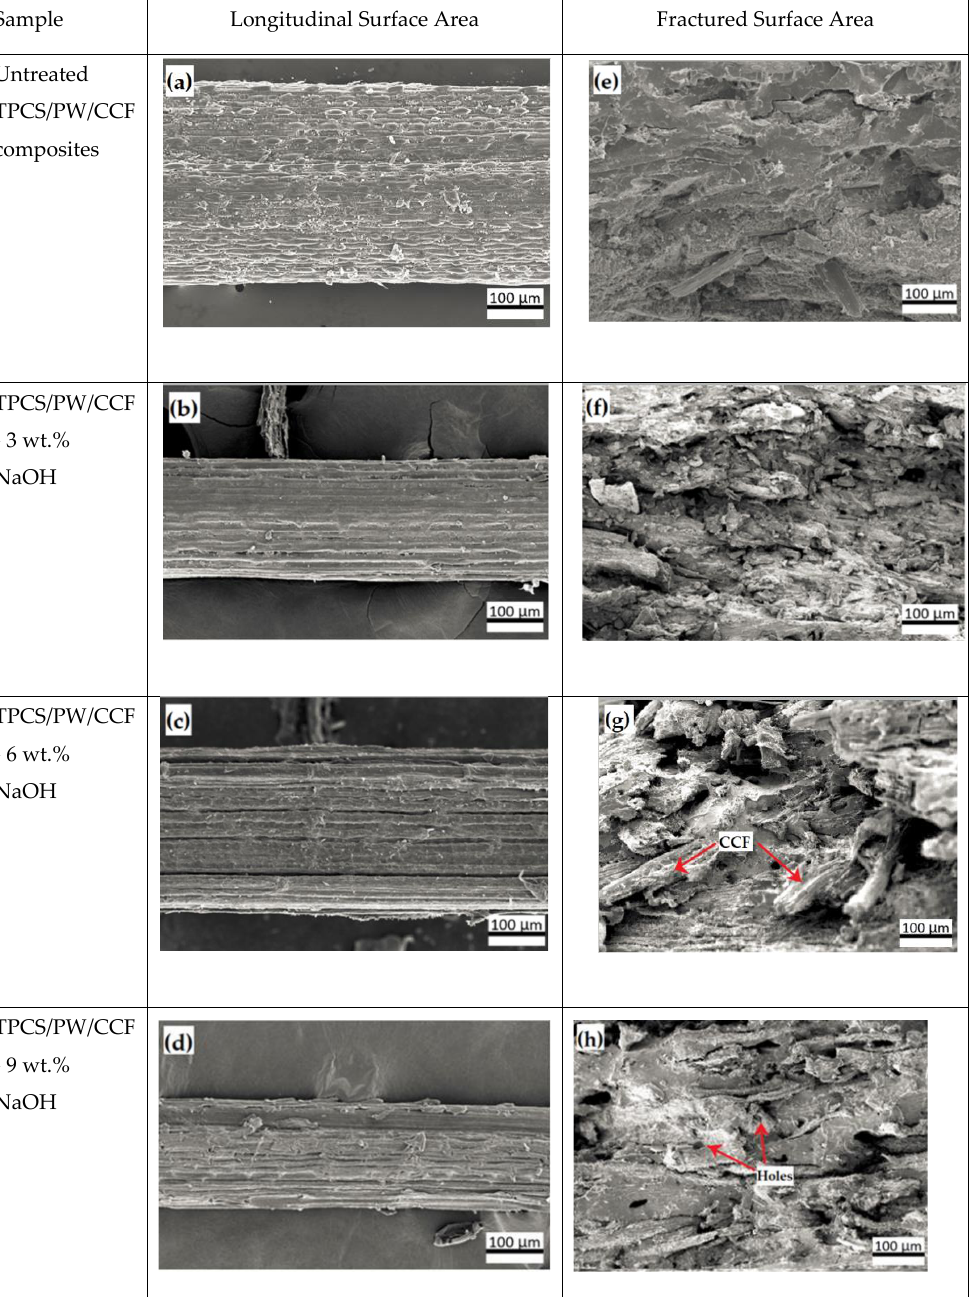
Figure 2. SEM images of untreated and treated TPCS/PW/CCF biocomposites from longitudinal surface and fractured surface views.